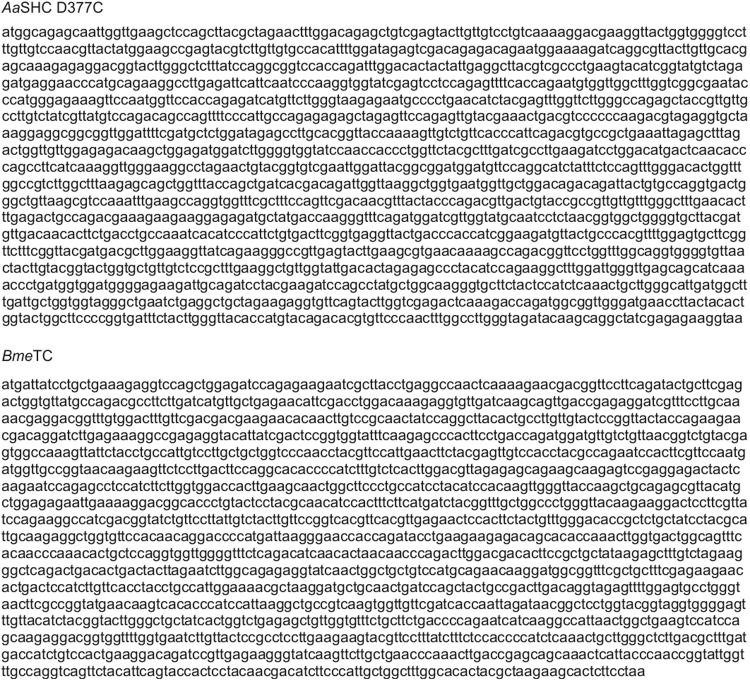
AaSHC and BmeTC sequences codon-optimize for expression in P. pastoris.